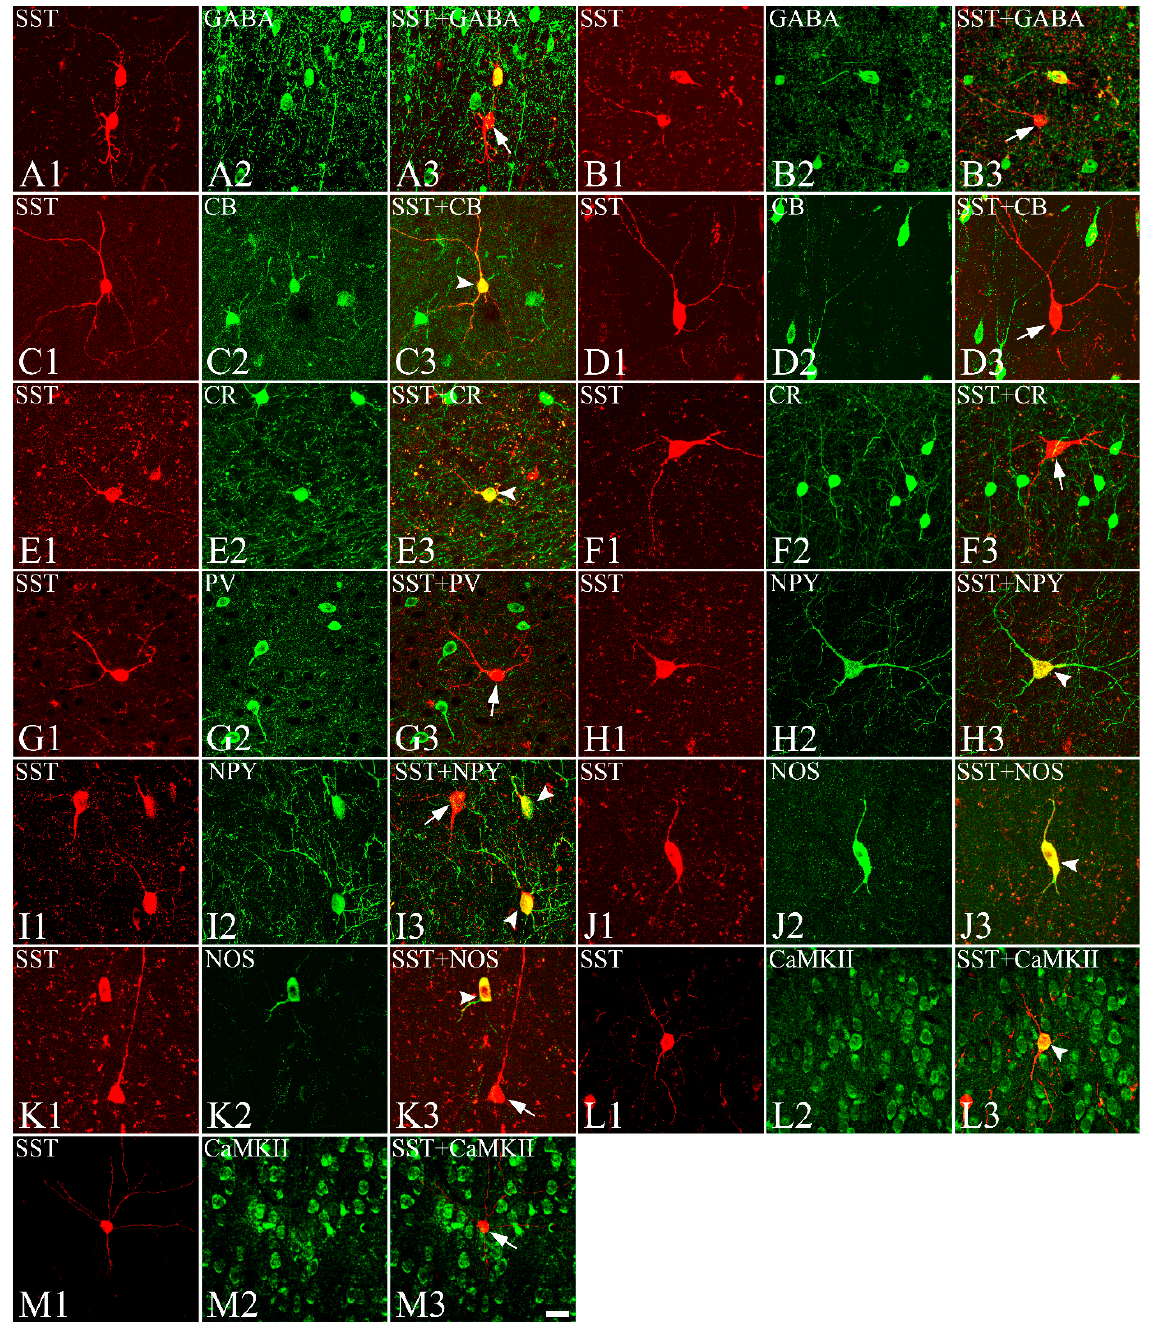
Figure 3. Fluorescence confocal photomicrographs of colocalization of SST neurons ( A1 , B1 , C1 , D1 , E1 , F1 , G1 , H1 , I1 , J1 , K1 , L1 , M1 ) labeled with Cy3, shown in red, with GABA- ( A2 , B2 ), CB- ( C2 , D2 ), CR- ( E2 , F2 ), PV- ( G2 ), NPY- ( H2 , I2 ), NOS- ( J2 , K2 ), or CaMKII-IR ( L2 , M2 ) neurons labeled with FITC, shown in green, and overlapped images of SST with GABA ( A3 , B3 ), CBPs ( C3 , D3 , E3 , F3 , G3 ), NPY ( H3 , I3 ), NOS ( J3 , K3 ), and CaMKII ( L3 , M3 ) in the gerbil VC. Some of the SST neurons co-expressed GABA (arrowheads in A3 , B3 ), CB (arrowhead in C3 ), CR (arrowhead in E3 ), NPY (arrowheads in H3 , I3 ), NOS (arrowheads in J3 , K3 ), or CaMKII (arrowhead in L3 ). However, none of the SST neurons co-expressed PV (arrow in G3 ). Single-labeled SST neurons were marked with arrows. SST, somatostatin; GABA, gamma-aminobutyric acid; CB, calbindin-D28K; CR, calretinin; PV, parvalbumin; NPY, neuropeptide Y; NOS, nitric oxide synthase; CaMKII, calcium/calmodulin-dependent protein kinase II. Scale bar = 20 μ m.